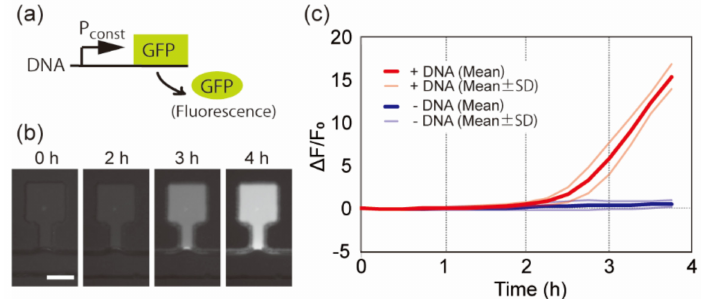
Figure 3. Protein synthesis using freeze-dried CFPS system and freeze-dried DNA. ( a ) Schematic diagram of the gene circuit demonstrated in ( b , c ). ( b ) Time-lapse fluorescent images of the repre- sentative microchamber freeze-dried together with the DNA shown in ( a ). The scale bar is 100 µm. ( c ) Time-course of the fluorescent intensities in the microchambers with (+DNA) or without DNA ( − DNA). SD shows standard deviation ( n ≧ 3 each). The freeze-drying condition of the microflu- idic device was ~30 mTorr, − 80 °C, 6 h.